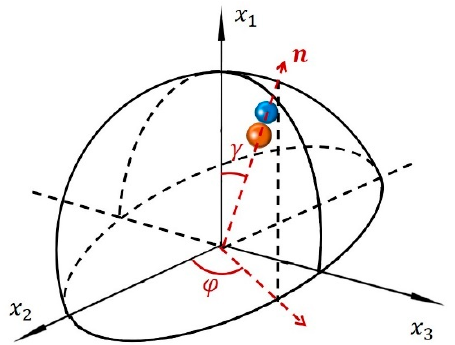
Figure 2. Relations of local and global coordinate systems.